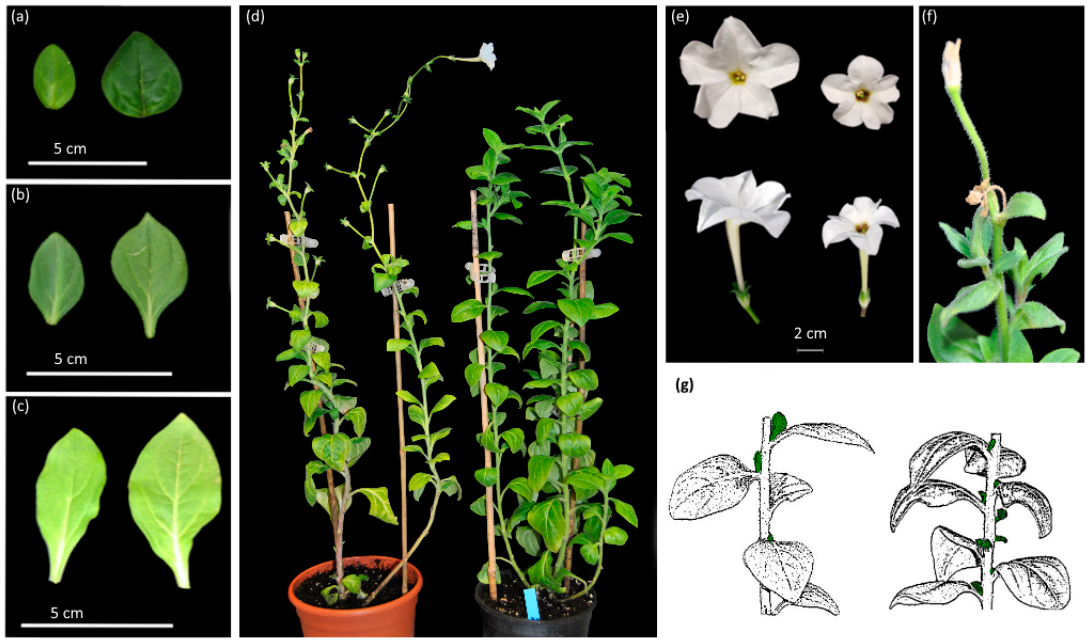
Figure 3. Phenotypic characteristics in Petunia x hybrida plants with loss of GI1 function. Apical ( a ), median ( b ) and basal ( c ) leaves of wild type Petunia (left) compared to iRNA: PhGI1 leaves (right). ( d ) Vegetative growth architecture of Petunia wild type (left) compared to the loss of PhGI1 function (right). Petunia inflorescence appearance ( e ) of wild type (left) and PhGI1 silenced line (right). Abortive flower ( f , g ) schematic representation of variations in internode length and number of axillary shoot meristems (indicated by the green colour) between wild type plants (left) and iRNA: PhGI1 plants (right).